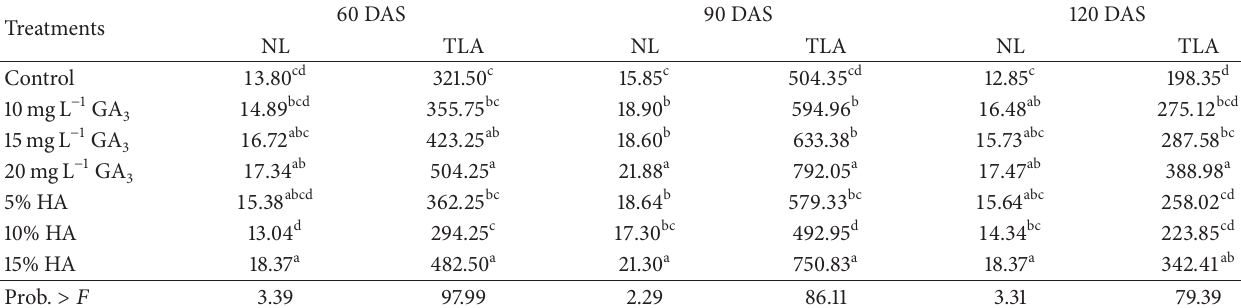
Table 3: Number of leaves and total leaf area (cm 2 ) per plant as affected by different concentrations of gibberellic acid (GA (HA).